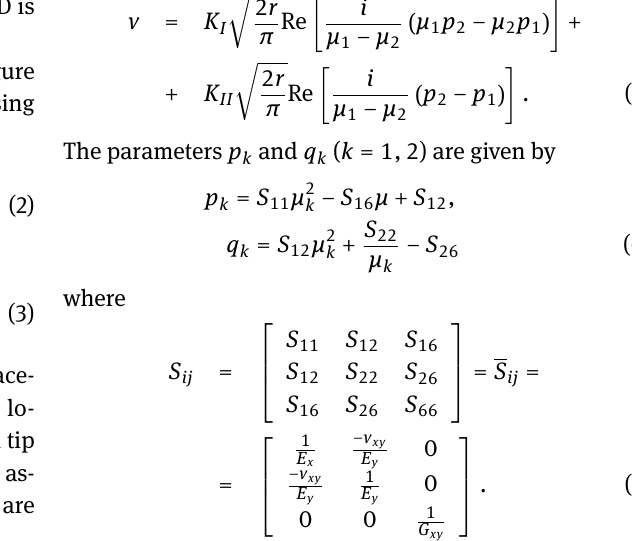
where COD is the crack opening displacement and CSD is the crack sliding displacement